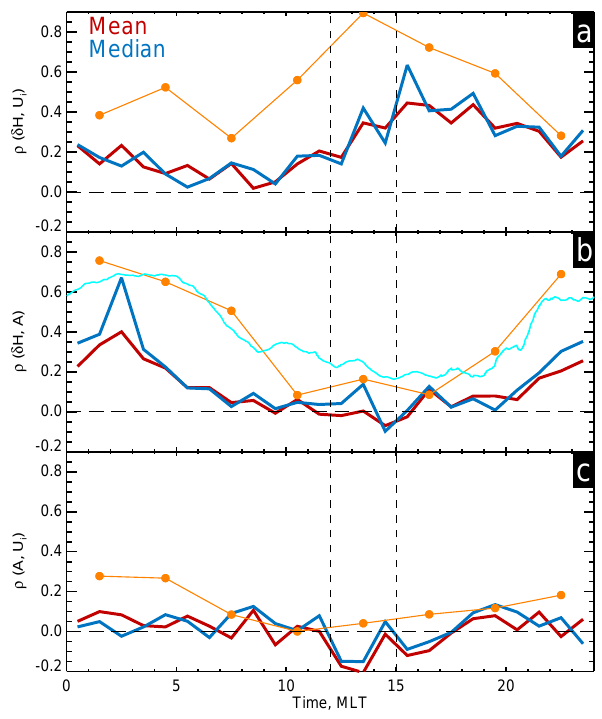
Fig. 8. Line plots of the hourly correlation co-efficients between (a) perturbation and velocity, (b) perturbation and absorption, and (c) absorption and velocity. The red (dark blue) line represents the mean (median) value of the hourly correlation co-efficients. The orange dots and lines represent the 3-hourly correlation coefficients from Figs. 3–5. In panel (b) the light blue line shows a 1-h boxcar correlation computed using an extended